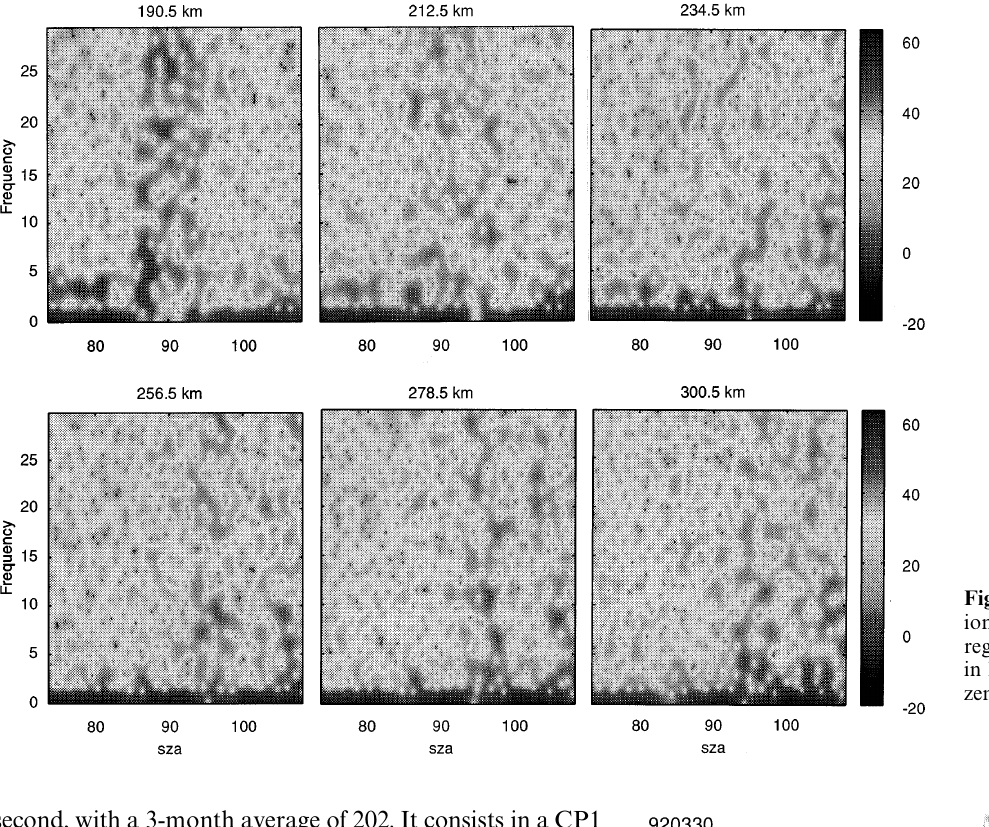
Fig. 13. Spectrograms of the ion velocity at different F- region altitudes; frequencies are in h (cid:126)(cid:49) ; SZA stands for solar zenith angle